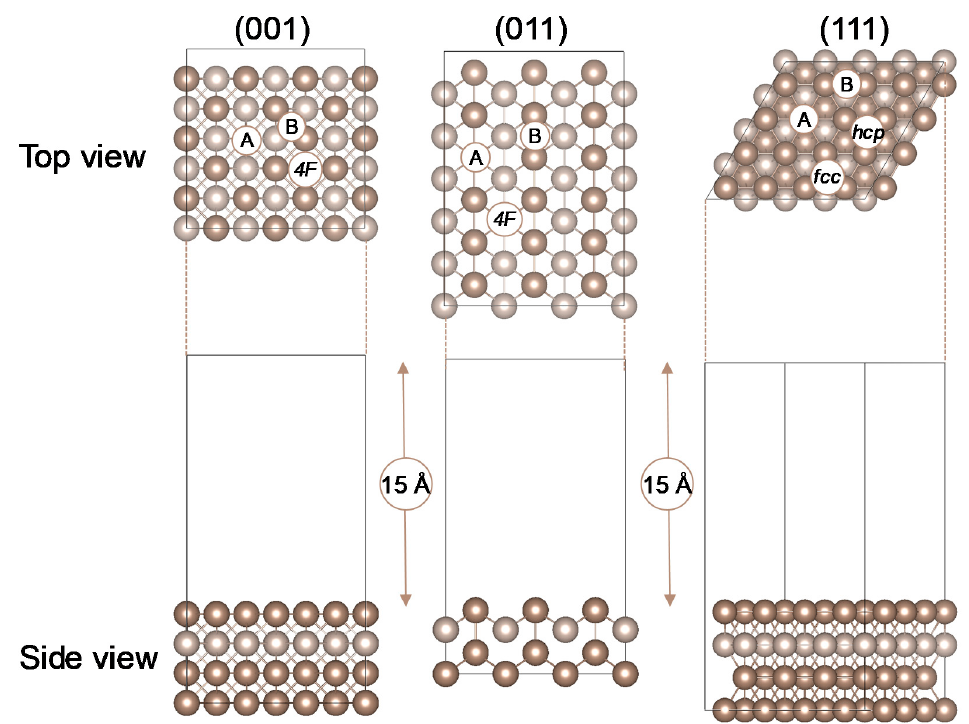
Figure 1. Top and side views of the Pt (001), (011), and (111) surfaces, with the four-fold hollow (4F), bridge (B), atop (A), face-cubic centred ( fcc ), and hexagonal close packed ( hcp ) adsorption sites. The gold colour is used to depict Pt throughout the manuscript, with the second layer in a lighter colour to distinguish between the top layer and subsequent layer atoms.